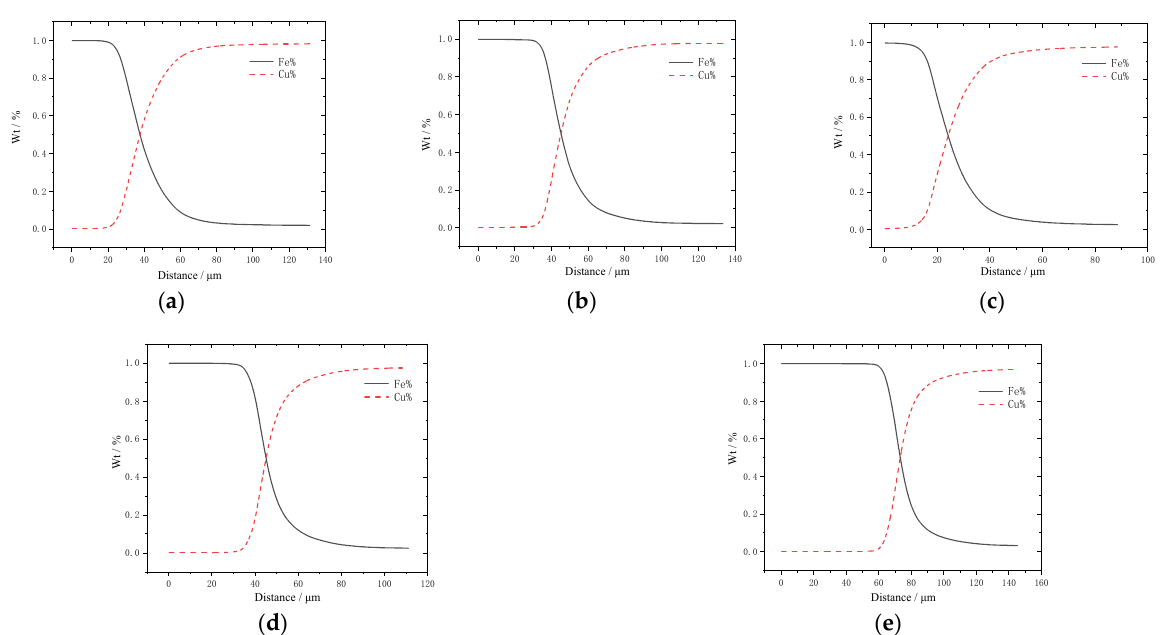
sults are shown in Figure 7a–e, wherein the content of Cu and Fe is the mass percentage.